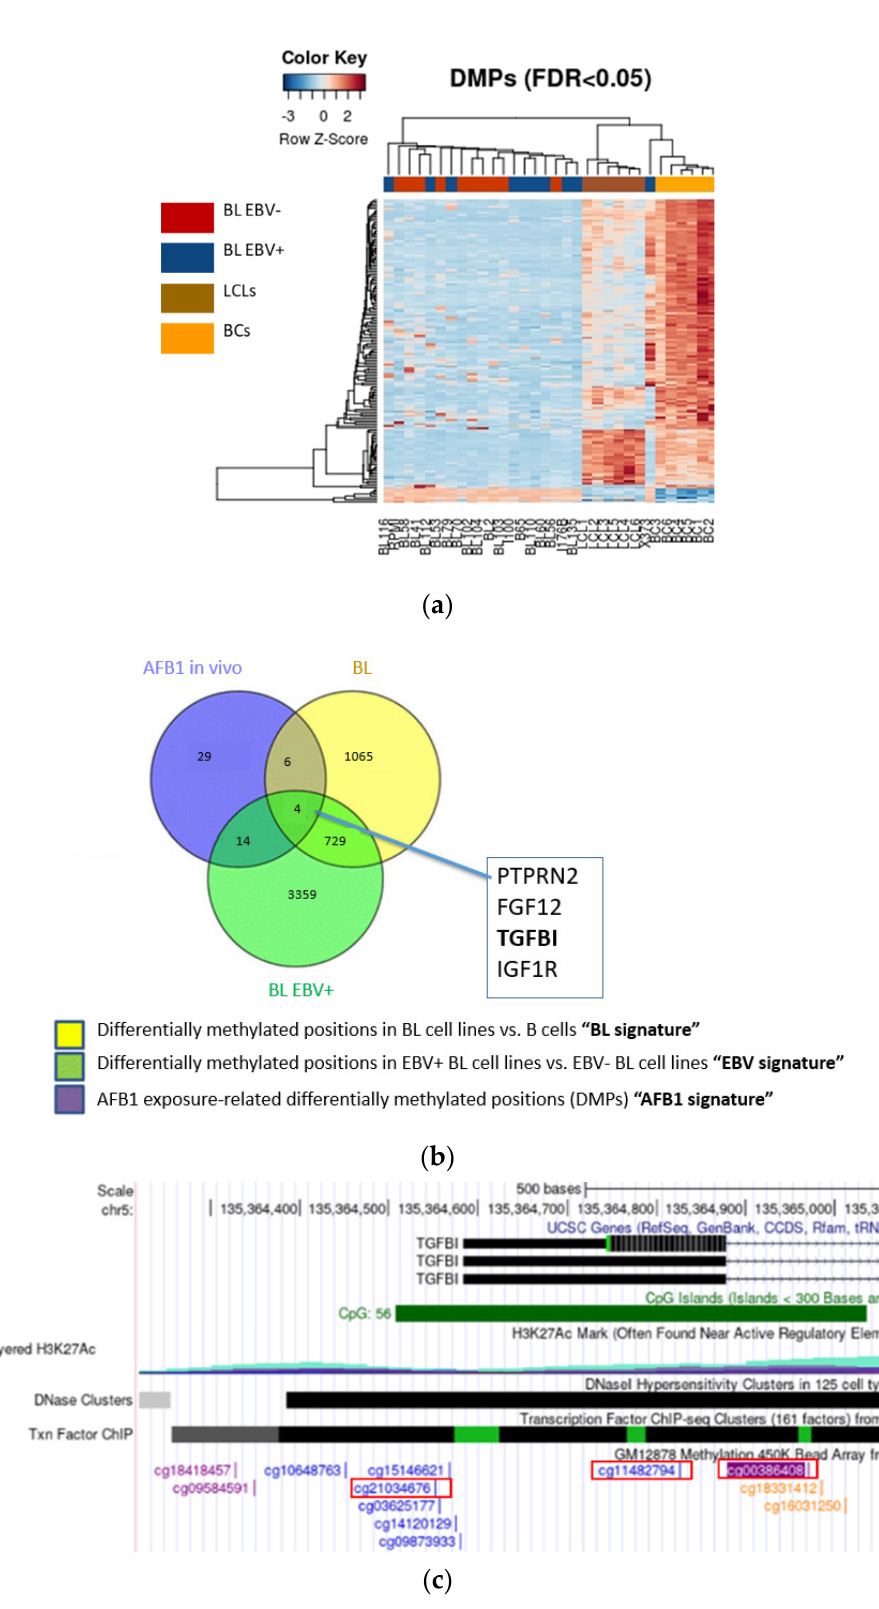
Figure 1. Identifying the methylation signatures of BL, EBV, and AFB1. ( a ) Heatmap of differentially methylated positions (DMPs) in the genome of EBV(+) and EBV(-) BL-derived cell lines, primary B cells, and lymphoblastoid cells (LCL). ( b ) Genes commonly affected by methylation changes